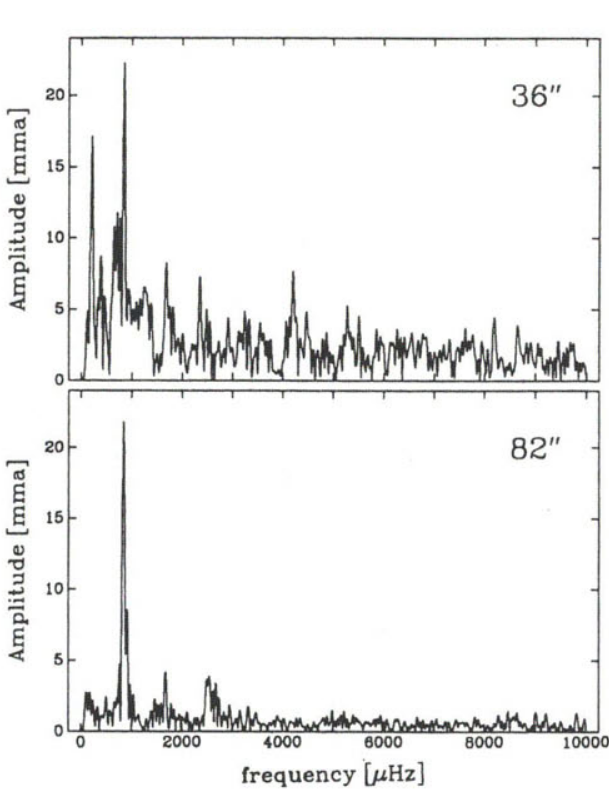
Fig. 2. Fourier (amplitude) spectra of single-telescope GD 154 runs. Top: 36" telescope; bottom: 82" telescope.